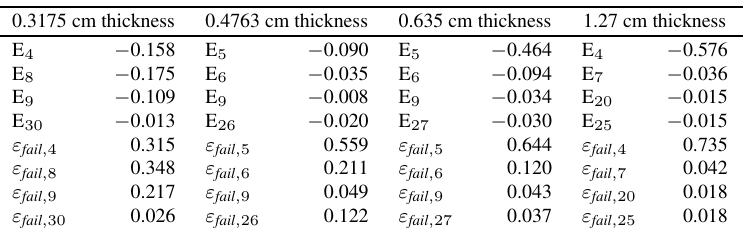
Table 7 Sensitivity vectors for structure of Fig.